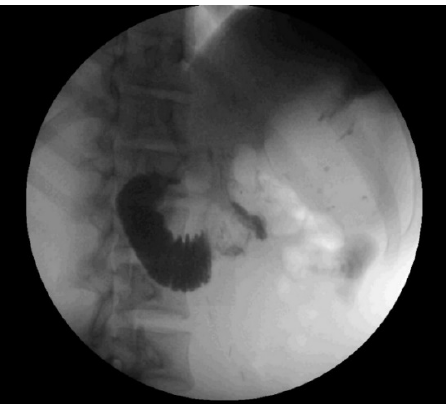
Figure 2. Representative image from upper gastrointestinal series showing abrupt cutoff of oral contrast in the mid-transverse duodenum, suggestive of superior mesenteric artery syndrome.